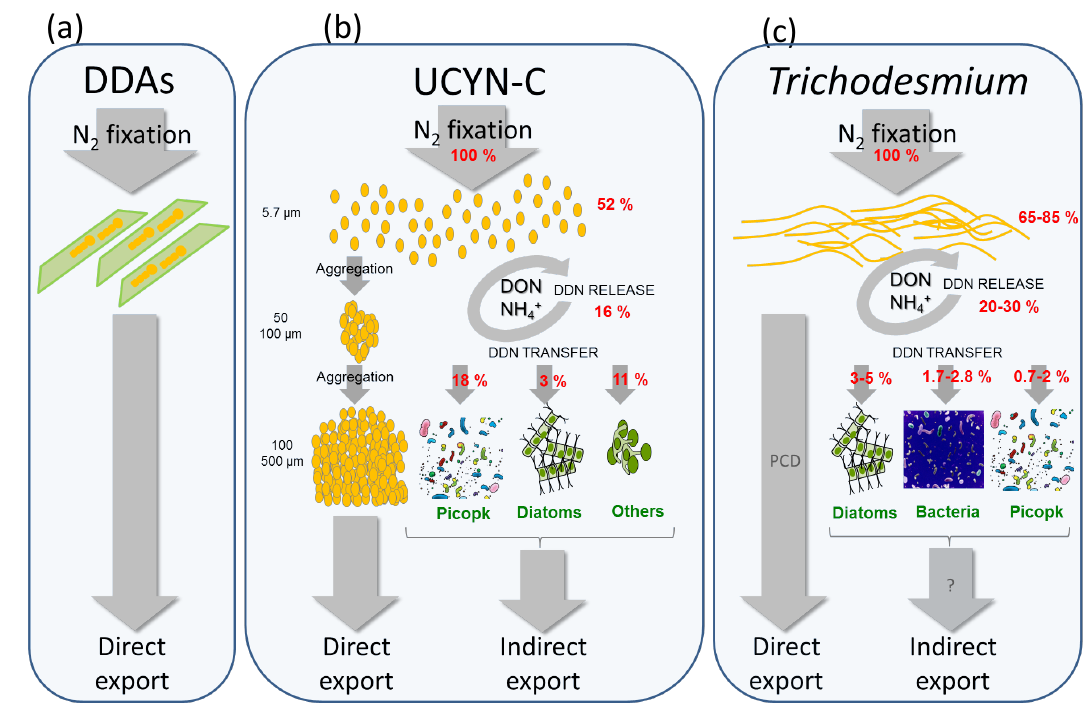
Figure 5. Summary of the simplified pathways of the potential DDN transfer in the first trophic level of the food web and potential of direct vs. indirect export of particulate matter for DDAs (a) , UCYN-C (b) and Trichodesmium (c) . DDN transfer data from (Bonnet et al., 2016a,